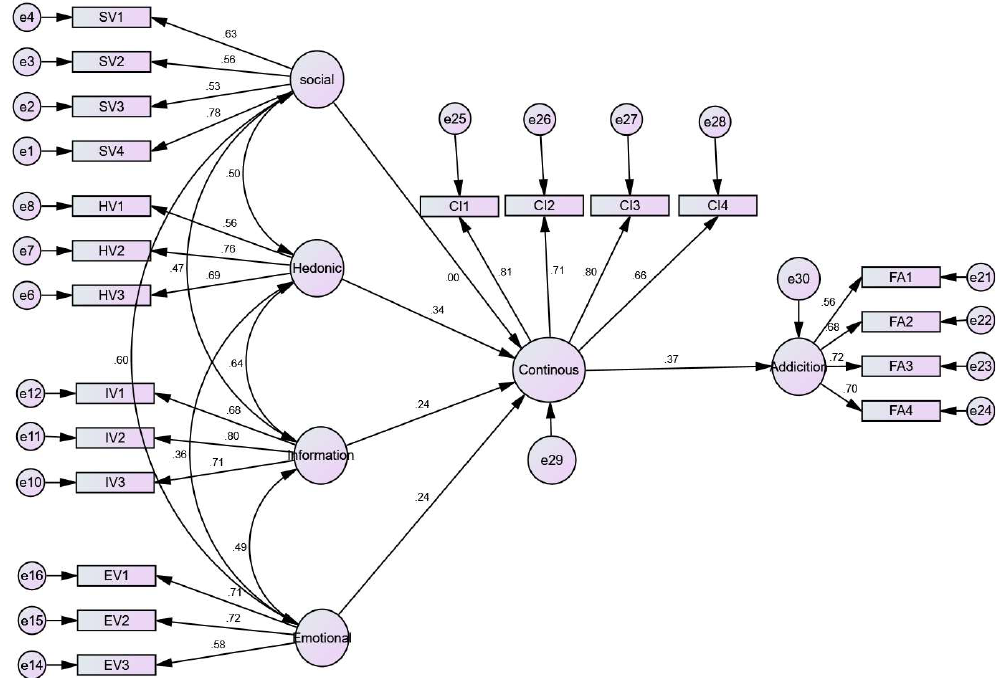
Figure 3. Path analysis for H1 to H5 (standardised values). Table 8. Result for testing H1 to H5.